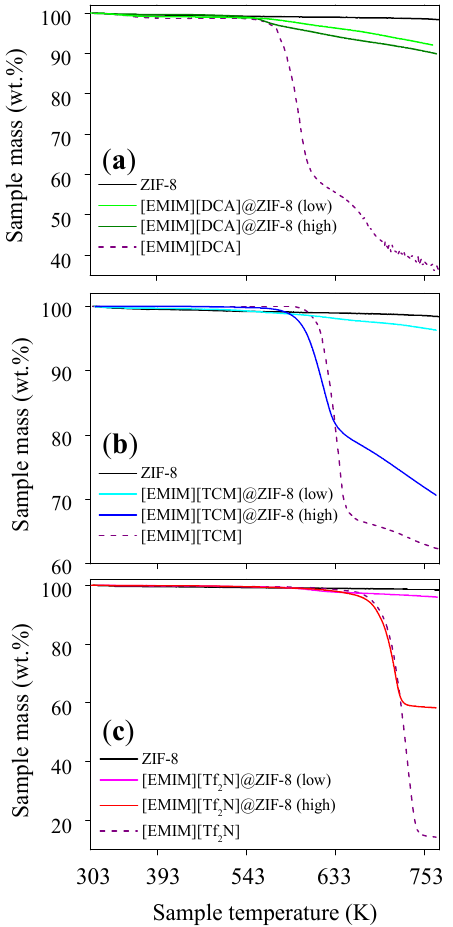
Figure 2. TGA profiles of pristine ZIF-8, neat ILs, and IL@ZIF-8 composites with ( a ) [EMIM][DCA]; ( b ) [EMIM][TCM]; and ( c ) [EMIM][Tf 2 N].